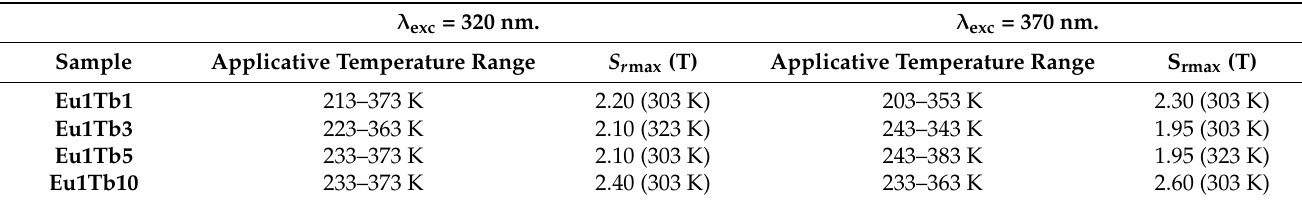
Table 2. Applicative temperature range (S r ≥ 1) and S r maximum value (S rmax ) of the studied Eu 3+ /Tb 3+ mixed samples. λ exc = 320 nm. λ exc = 370